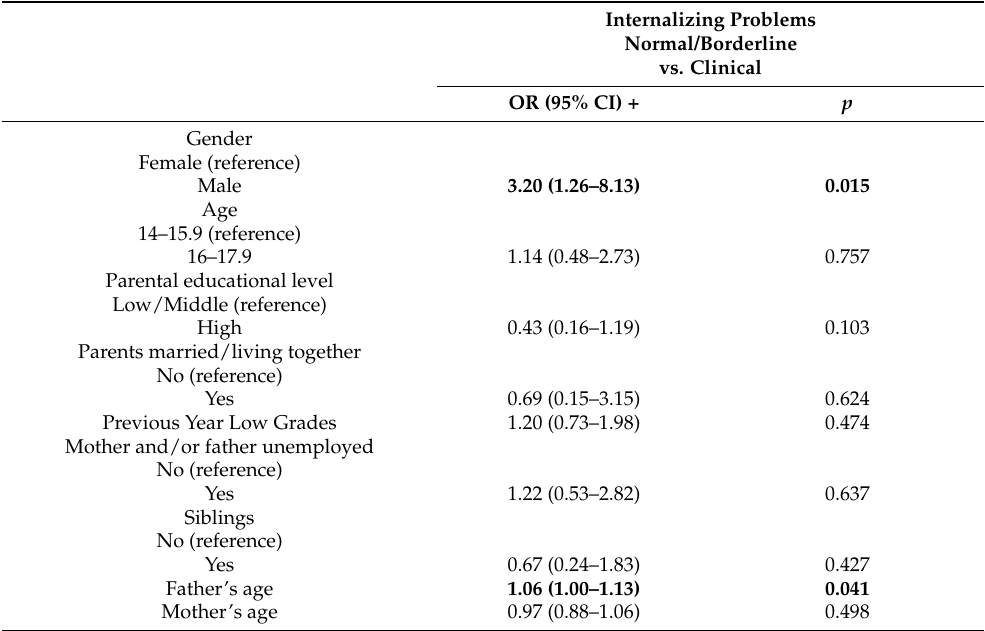
Table 7. Results from multiple logistic regression analysis with clinical internalizing problems as the dependent variable for Romania. Bold cells denote statistically significant associations.